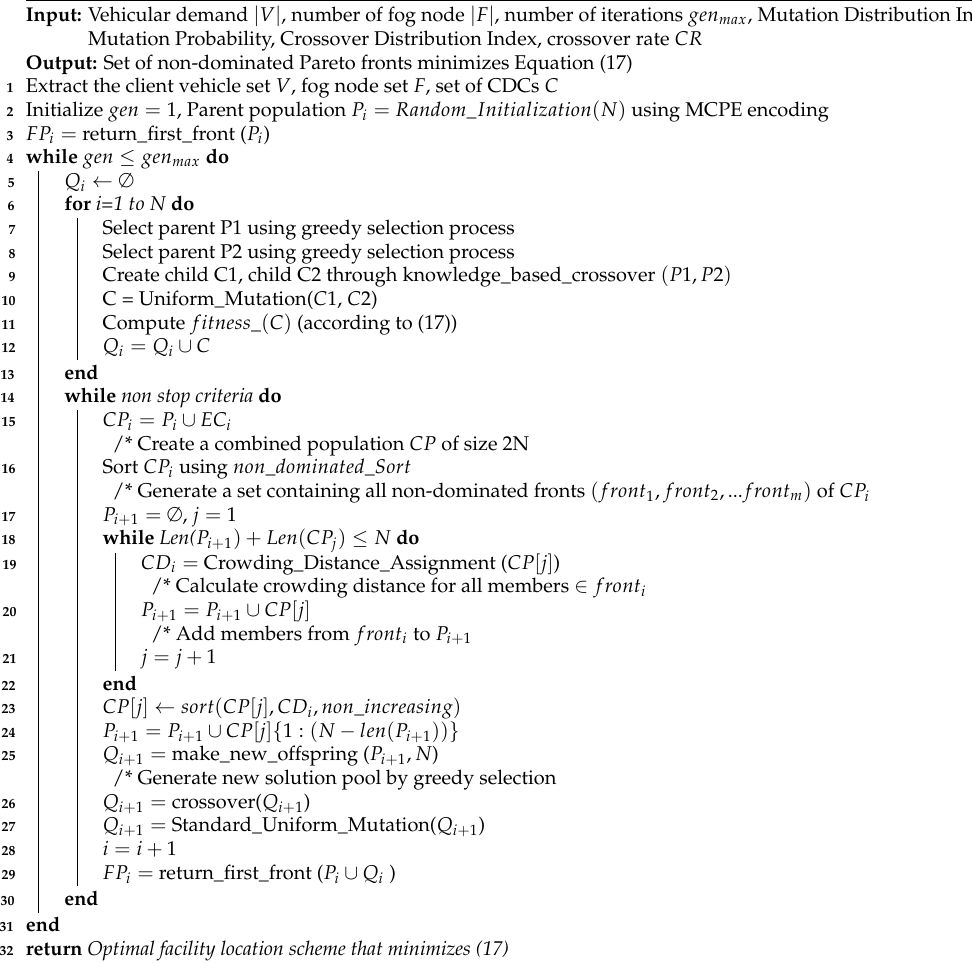
Algorithm 1 NSGA-II Algorithm for facility location in VFC